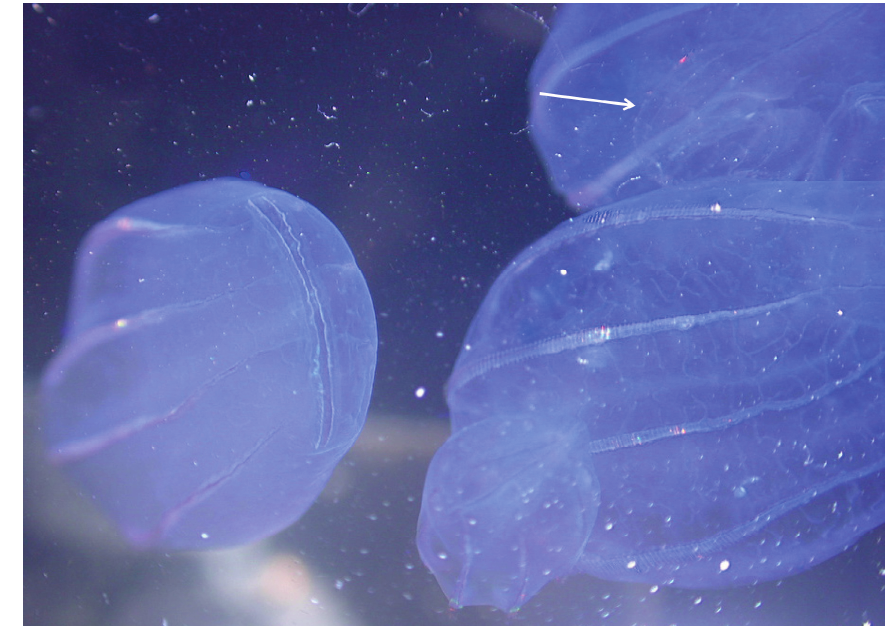
Figure 7. Beroe ovata collected in Limfjorden 20 November 2013. Note the prey organism ( Mnemiopsis leidyi ) in the gastrovascular cavity of the B. ovata in upper right corner (arrow). Photo: Hans Ulrik